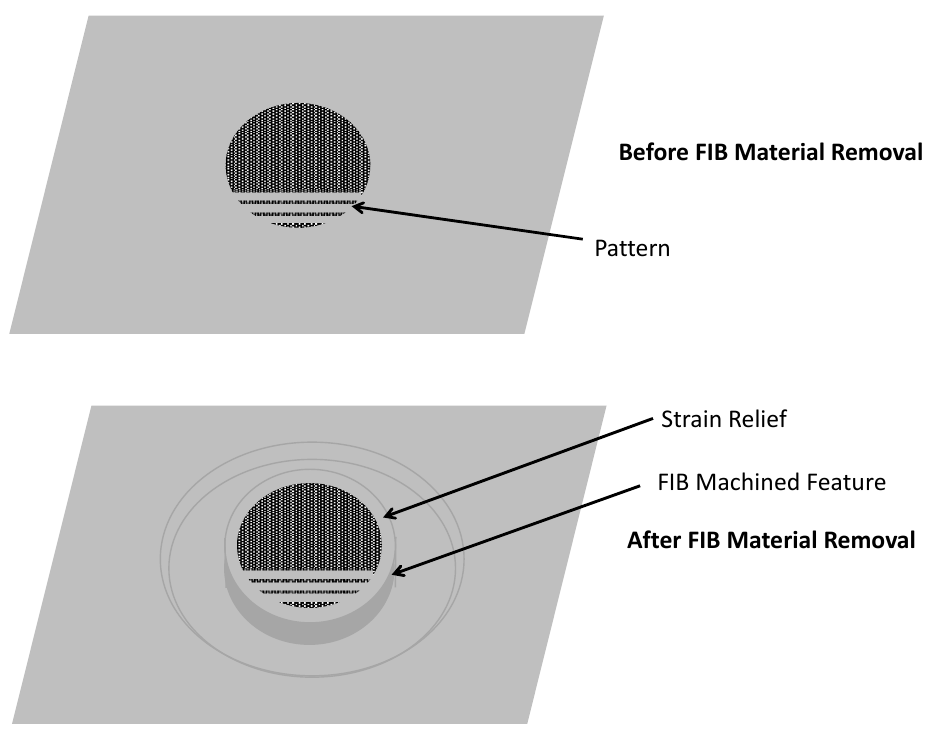
Figure 19. Illustration of FIB machining to measure residual stress in a thin-film material layer.